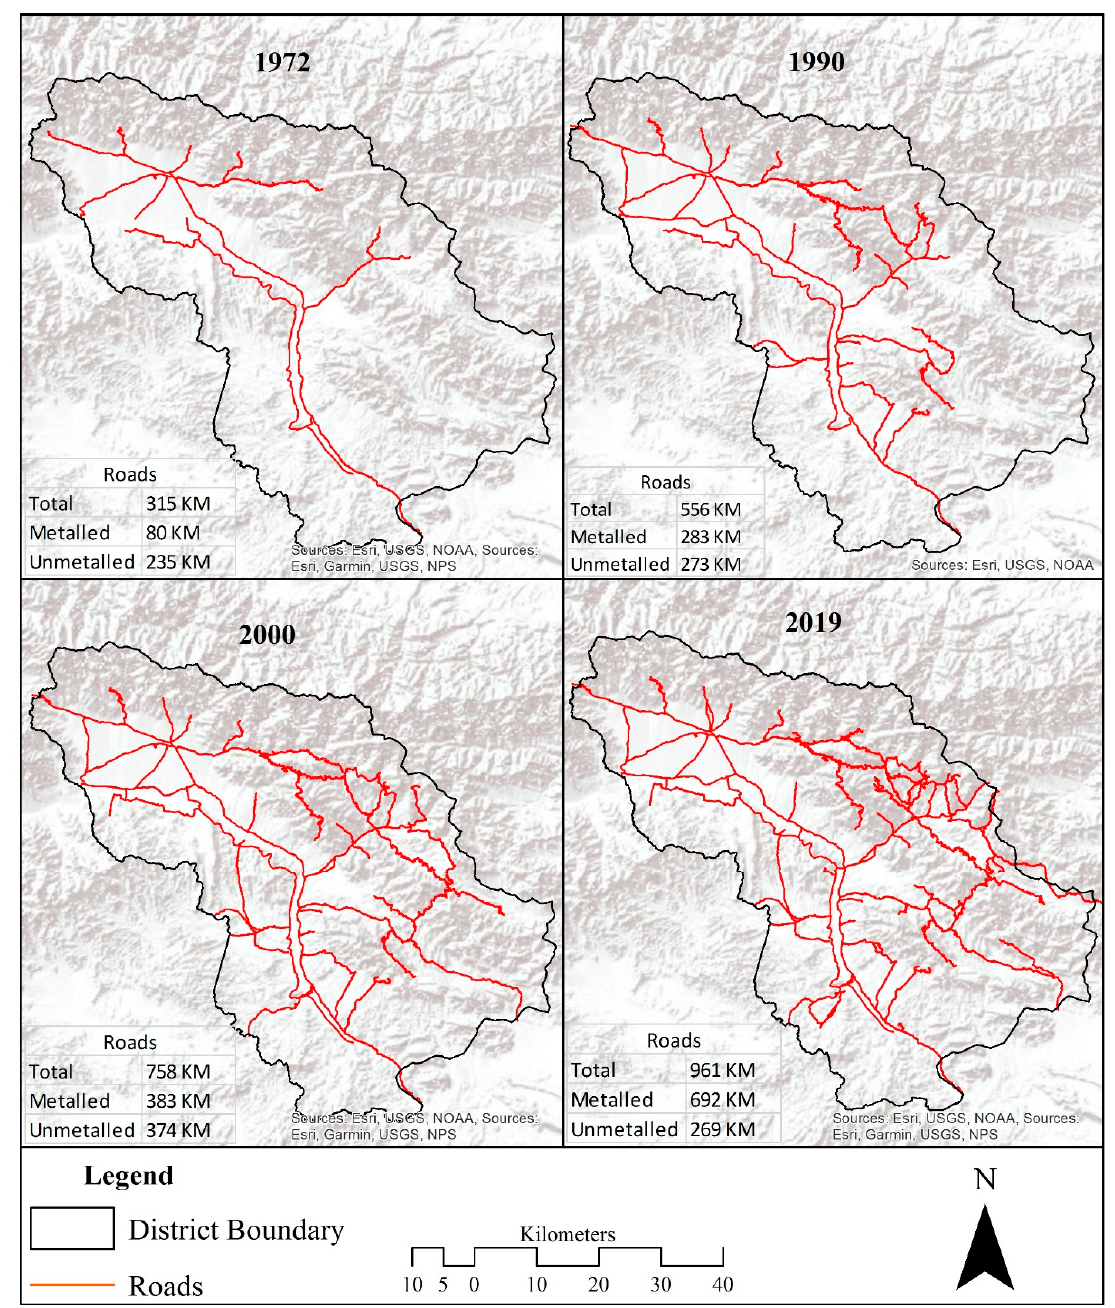
Figure 7. Road length in different years. Source: [58–60] (Construction and Work Department Parachinar 2019). Table 9. Correlations between road length and forest cover